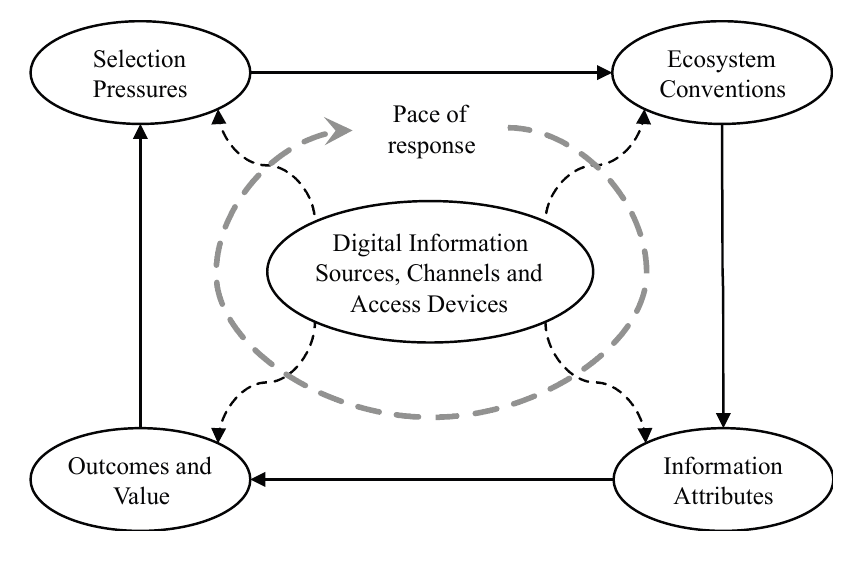
Figure 2. Pace of Response to Selection